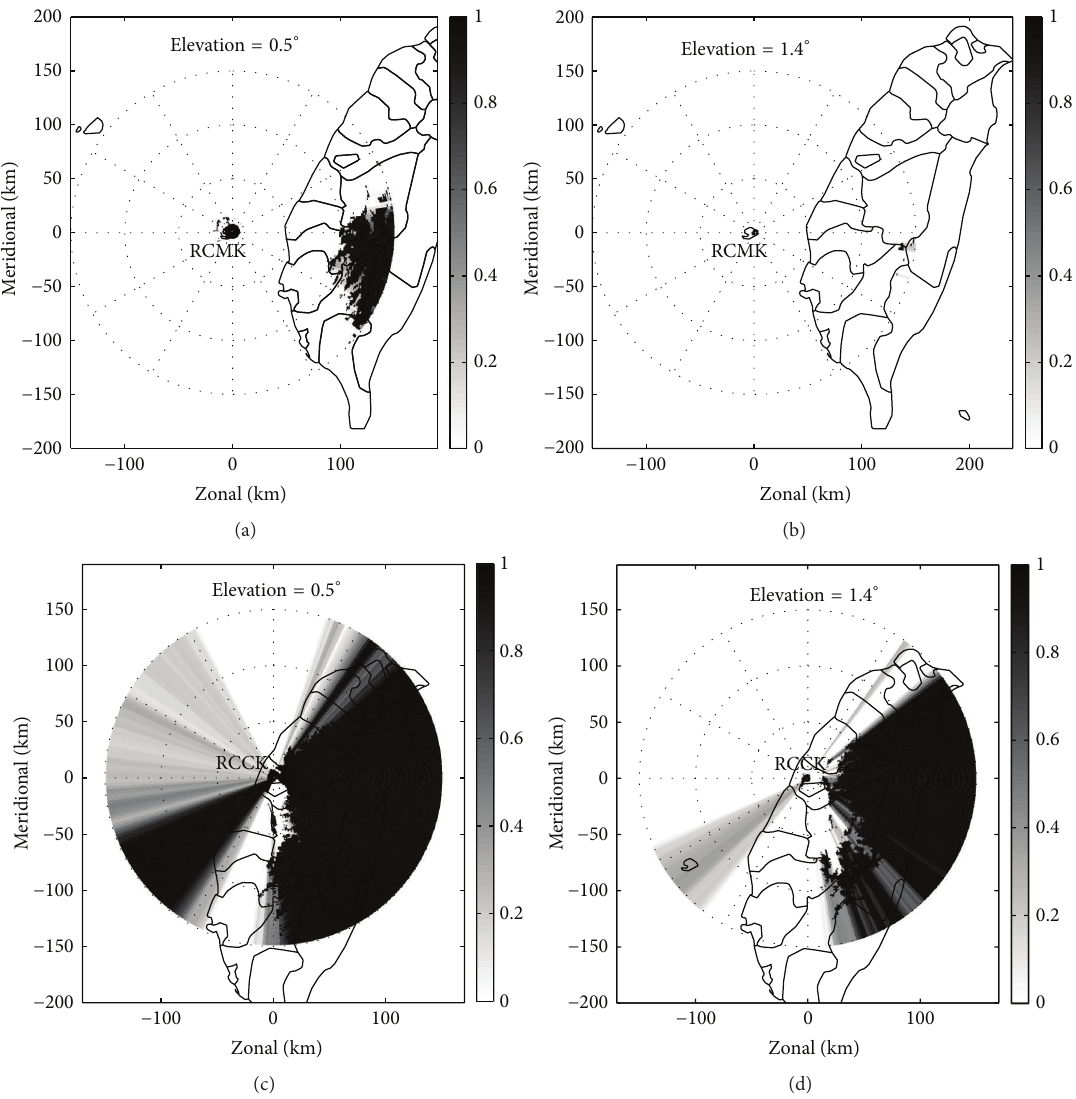
Figure 2: The blockage percentages from the first two tilts of RCMK (a and b) and RCCK (c and d). The color map indicates the blockage